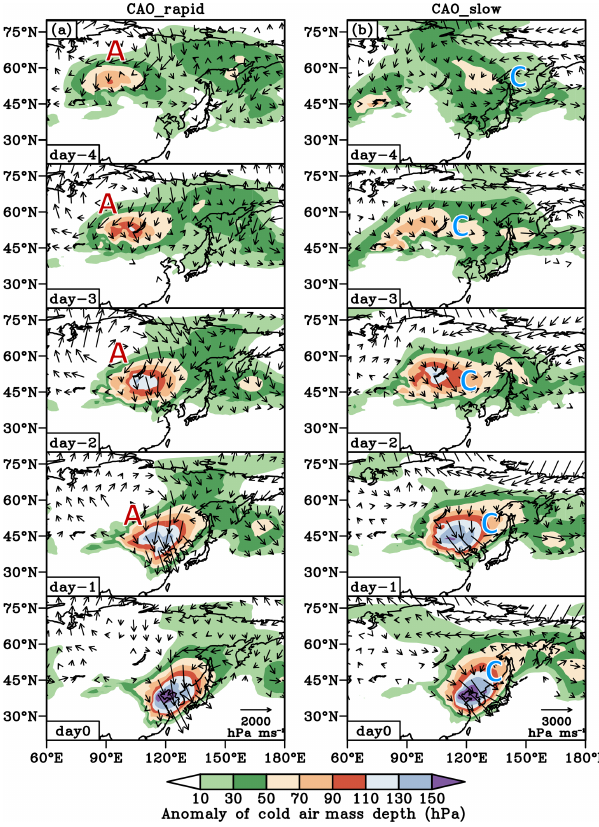
Figure 14. Large-scale anomalies of cold air mass depth (shading) and cold air mass flux (vectors) in the initial stage from day − 4 to 0. Panels (a) and (b) are composited by the CAO_rapid events and CAO_slow events,